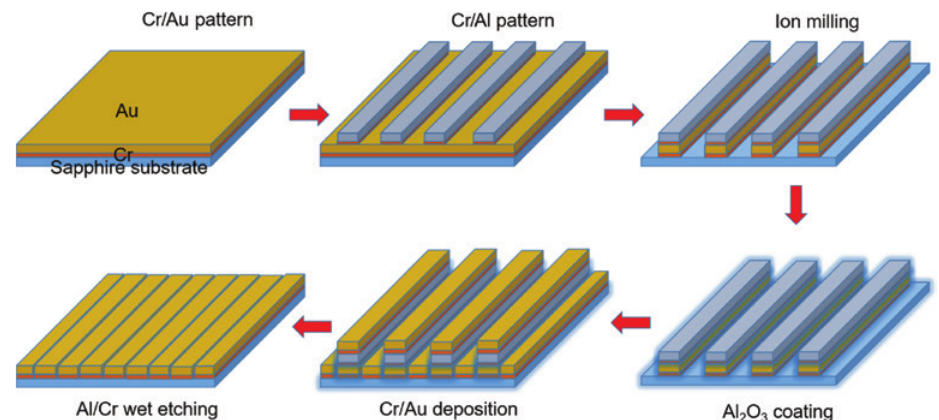
Figure 18: High-throughput fabrication of arrays of nanoslits with ultrahigh aspect ratio introduced by Jeong et al. [102].